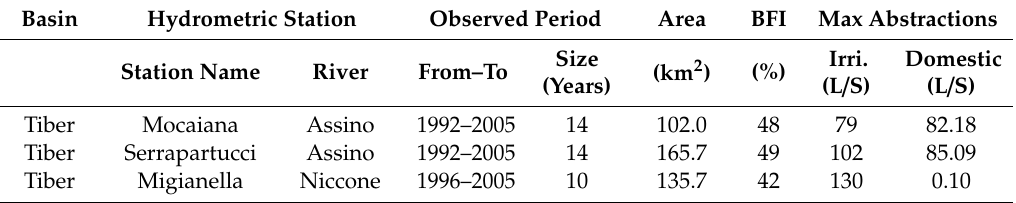
Table 1. Key characteristics of case study basins: observation periods, catchment area, Base Flow Index, and water abstractions.